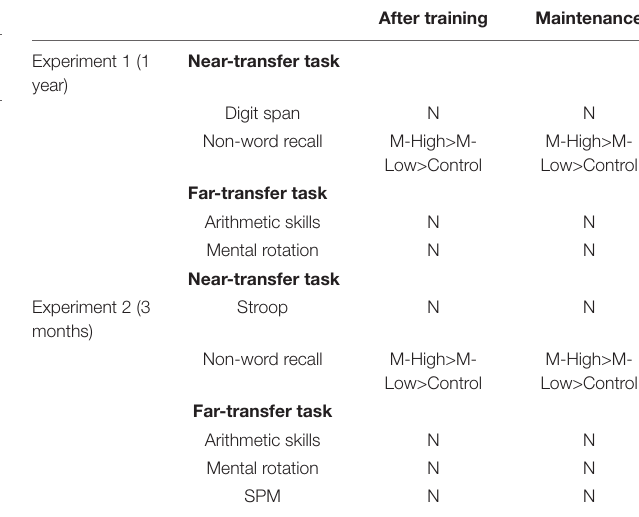
TABLE 19 | Summary of experiment